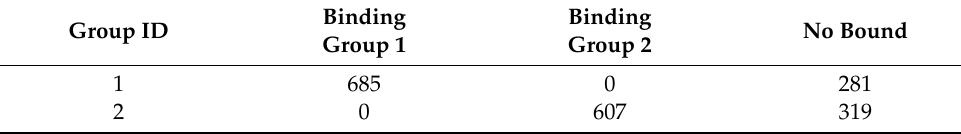
Figure 13. Group filtering deployment. Table 2. The number of successful positioning in three testing cases.